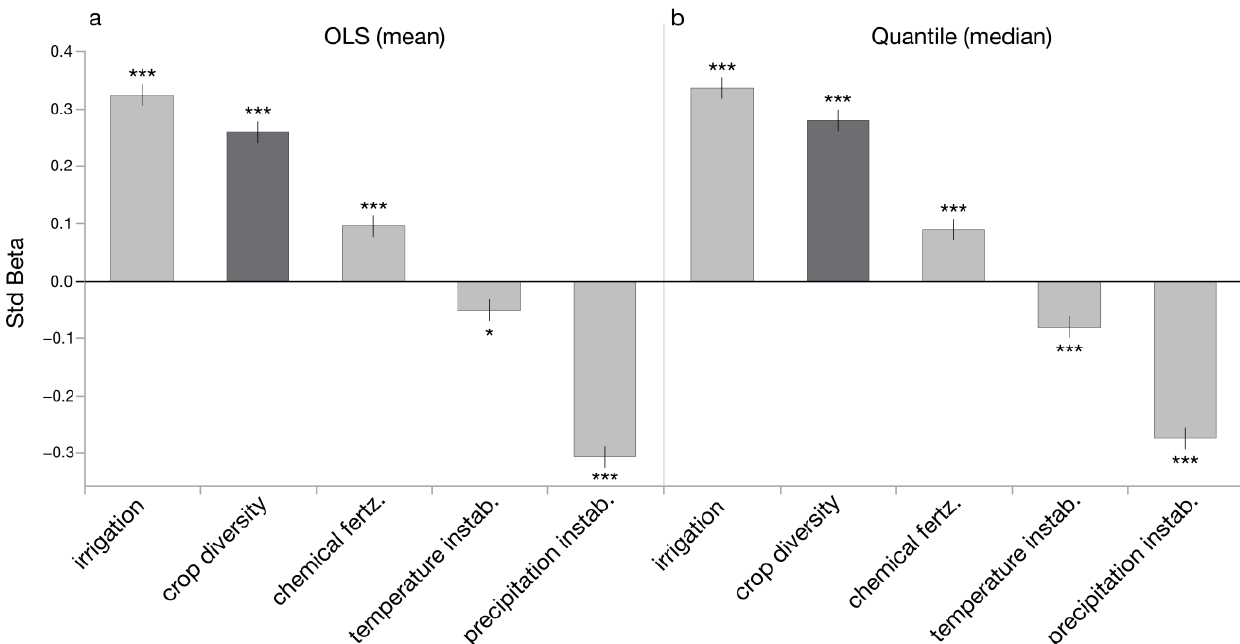
Figure 2. Results of Model 1 showing standardized effects of crop diversity (shaded dark gray) and other predictors (shaded light gray) on crop revenue stability (relative) in southern Mexico for ( a ) standard ordinary least squares (OLS) and ( b ) quantile (median) regressions. All variables were transformed and standardized (z-scored) to meet OLS model assumptions and to facilitate comparison of results (for transformation details, see end of Section 2.5). * p < 0.05, *** p < 0.001.